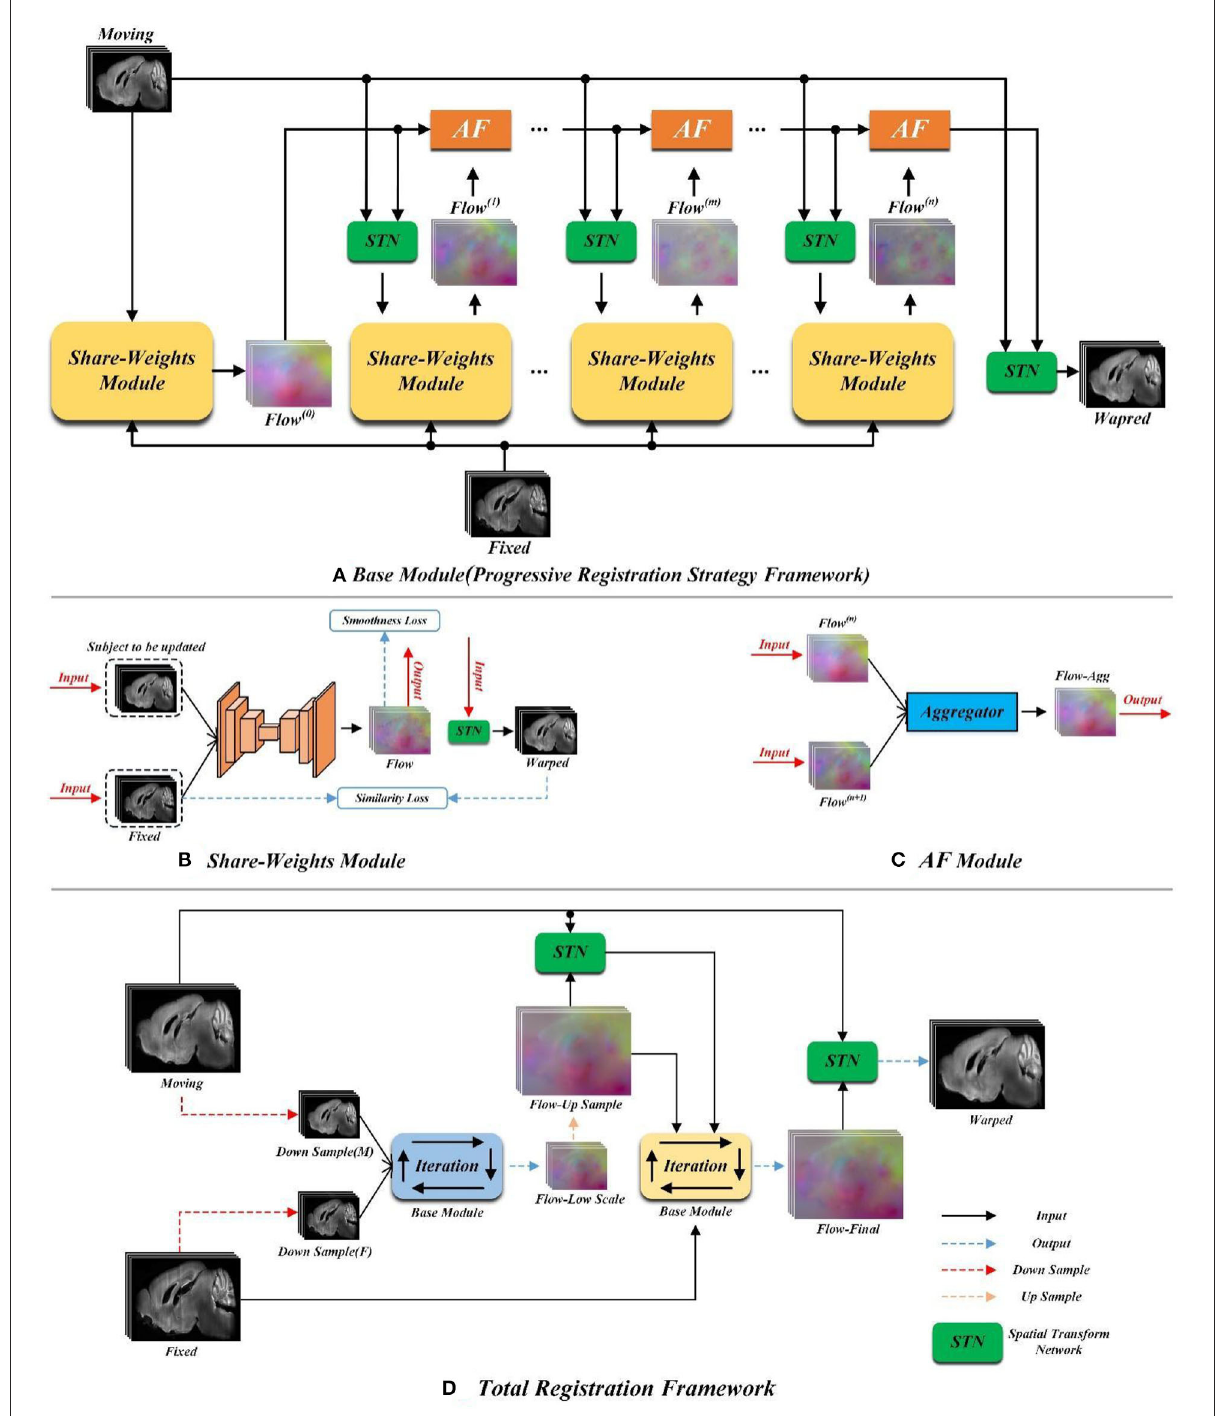
FIGURE2 The pipeline of the proposed method. (A) Schematic diagram of the progressive registration strategy. (B) The structure of the yellow shared parameter module in (A) . (C) Schematic diagram of orange AF module in (A) . (D) Schematic diagram of total registration